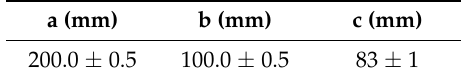
Table 1. Geometric size of a mimicked